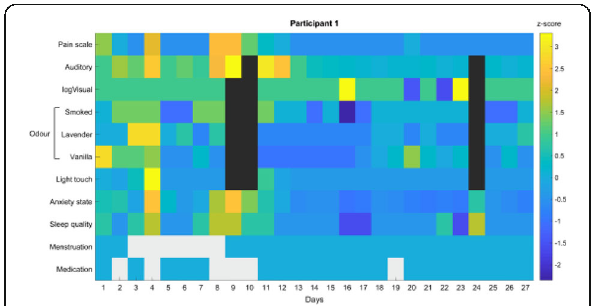
Figure 1. Example of one participant's data. Z-scores of the measured aversion thresholds/scores, anxiety-state, and sleep quality over 27 days. Missing data was filled in black, while presence of menstruation/ medication intake were filled in grey. Colours of the z-scores for the auditory/visual thresholds were inverted to ease interpretation.